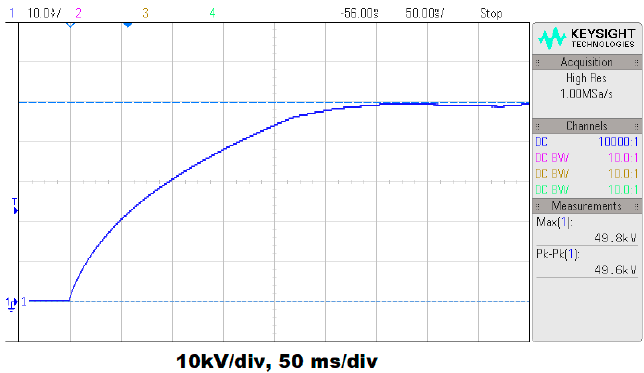
Figure 16. Charging of the Marx generator to 50 kV.